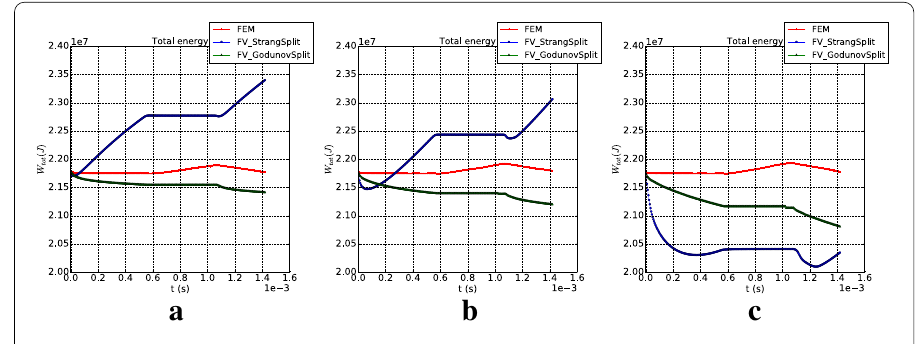
Fig. 6 Time evolution of the total energy (kinetic plus strain energies) shown for different values of the relaxation time τ , computed with a CFL number of one, with the elastic–viscoplastic finite element (FEM), finite volume (FV) with Strang and Godunov splitting numerical solutions. a τ = 10 − 4 s. b τ = 4 . 8 × 10 − 6 s. c τ =